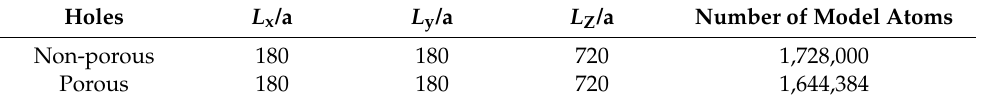
Table 1. Specific parameters of NiTi shape-memory alloy molecular dynamics model.